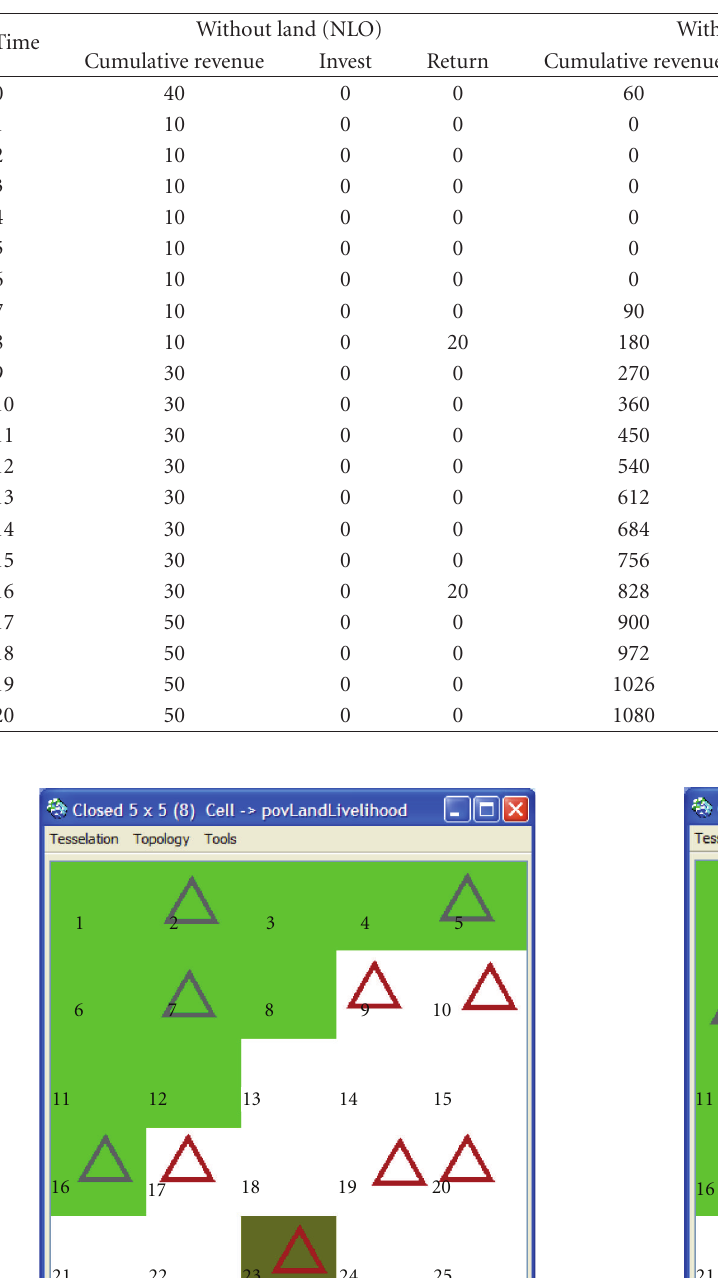
Table 4: The players’ cumulative revenue under scenario C (million rupiahs).